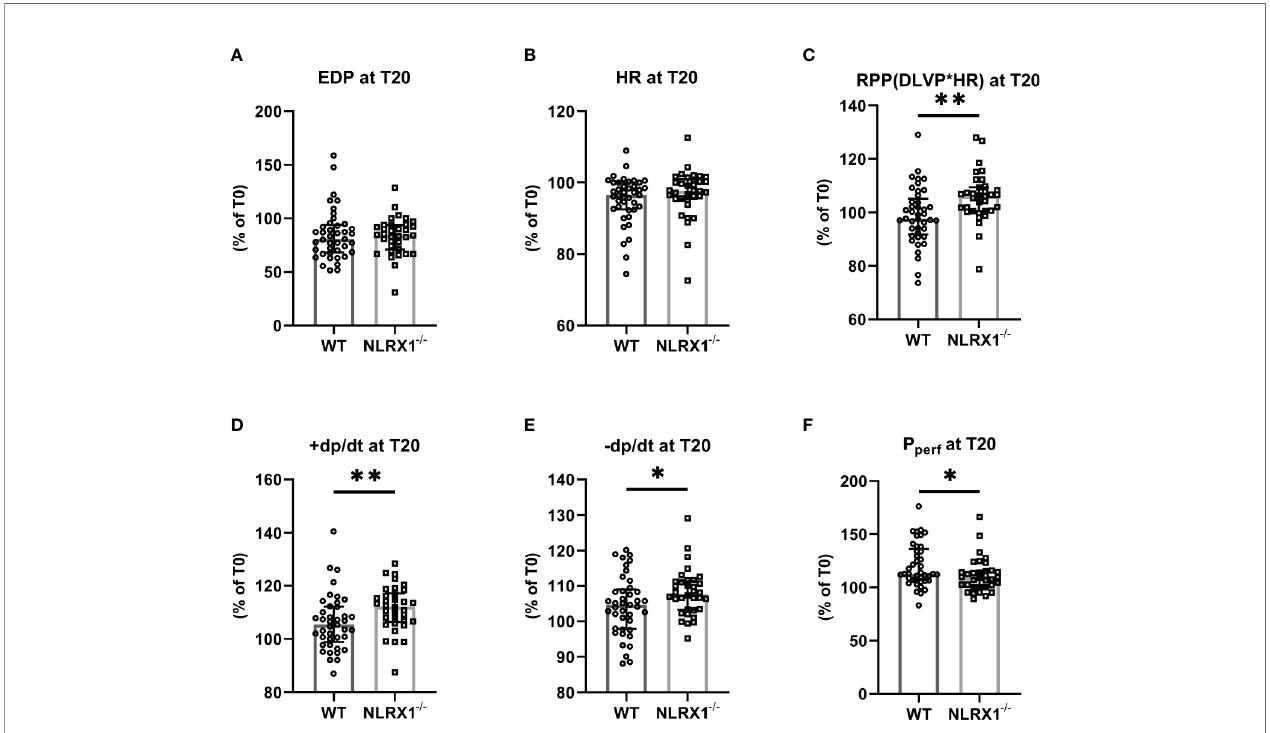
FIGURE 2 | The impact of NLRX1 deletion on maintenance of mechanical function during 20 min normoxic perfusion in the isolated hearts of protocols 1 to 5. For all parameters, the change in parameter at T=20 min relative to the value at T= 0 min is depicted. (A) end diastolic pressure (EDP), (B) heart rate (HR), (C) Rate Pressure Product (RPP), (D) maximum contraction rate of left ventricle (+dp/dt), (E) maximum relaxation rate of left ventricle (-dp/dt), and (F) Perfusion pressure (P perf ). DLVP, developed left ventricular pressure. All values represent median ± IQ (n=41 in WT group; n=34 in NLRX1 -/- group). * P < 0.05, ** P < 0.01 by Mann-Whitney U